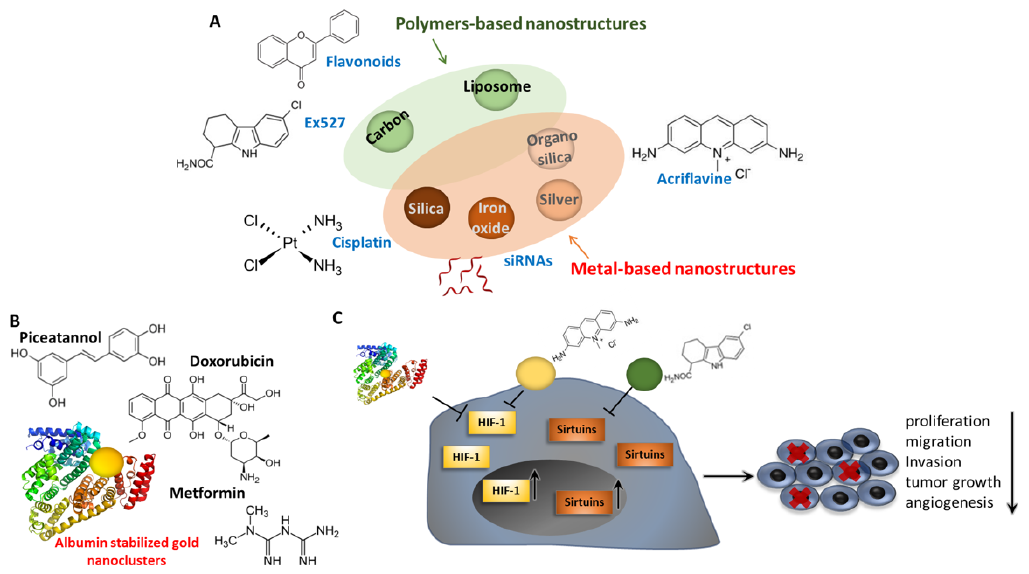
Figure 7. Schematic illustration of how different nanomaterials have been used or could be used to deliver nucleic acids or drugs to modulate hypoxic response and/or sirtuins in order to modulate the EMT process. ( A , B ) Modulators of sirtuins and/or HIF, such as natural compounds (Piceatannol, Flavonoids), drugs (Metformin, Doxorubicin, Cisplatin), and antibiotics (Acriflavine), could be delivered by polymer-based nanostructures, such as liposomes, Albumin stabilized gold nanoclusters or metal-based nanostructures , such as gold nanoclusters, iron oxide, etc. ( C ) pathways activated by hypoxia or sirtuins leading to EMT activation could be inhibited, preventing cancer-cell proliferation, tumor growth, invasion, migration and angiogenesis.